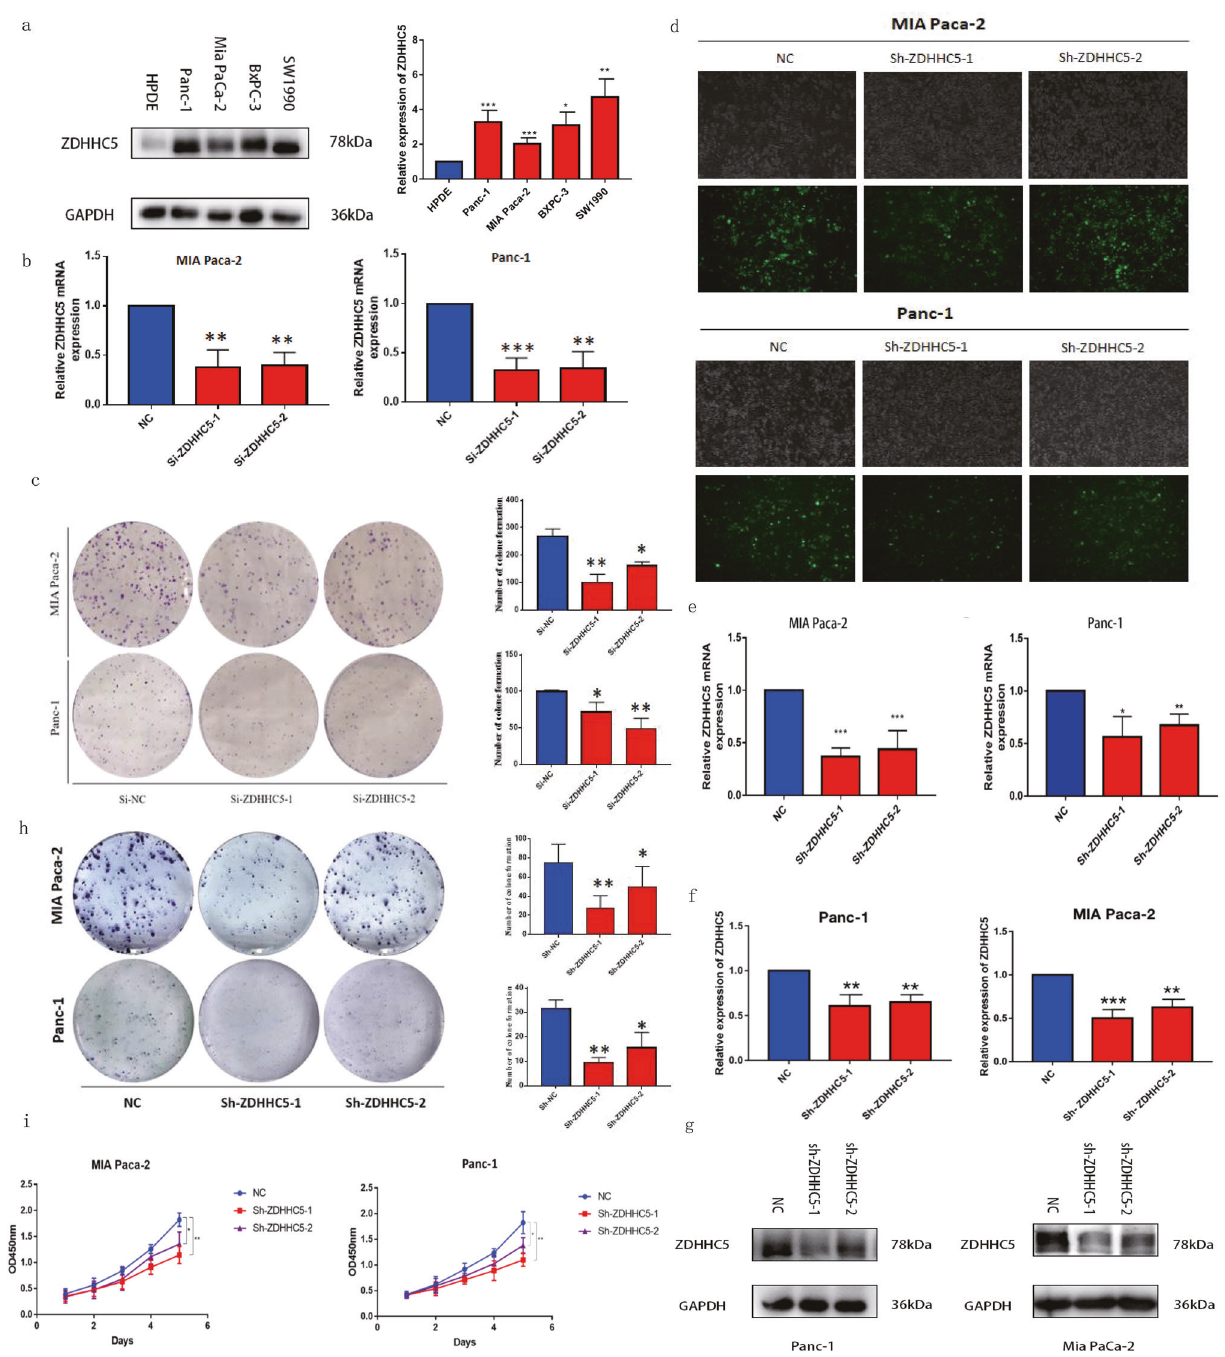
Fig. 2 In vitro evaluation of silencing ZDHHC5 anti-tumor effect. a ZDHHC5 is upregulated in pancreatic cancer cell lines. Western blot analyses of ZDHHC5 expression in HPDE cell and 4 PDAC cell lines. b ZDHHC5 mRNA expression after transfection analyzed by RT-qPCR. c After transfection, colony formation assay of cell viability in MIA Paca-2 and Panc-1 cell lines after cultured 15 days. d Establishment of stable ZDHHC5 knockdown pancreatic cancer cell lines. MIA Paca-2 and Panc-1 cells were transduced with a lentivirus vector containing negative control ShRNA (NC) or one of two ShRNAs against ZDHHC5 (Sh-ZDHHC5-1 and Sh-ZDHHC5-2) for 48 h. Morphology of MIA Paca-2 and Panc-1 cells was captured. e mRNA expression of stable ZDHHC5 knockdown cell lines were analyzed by RT-PCR. f , g Knockdown ef fi ciency on protein level was detected using Western blot. h After construction of stable ZDHHC5 knockdown cell lines, colony formation assay of cell viability in MIA Paca-2 and Panc-1 cell lines after cultured 15 days. i Transduced MIA Paca-2 and Panc-1 cells were cultured for 5 days post transduction. The absorbance at 450 nm was measured with a microplate analyzer every 24 h to assess cell growth. Data are expressed as mean ± SEM ( n = 3) * p < 0.05, ** p < 0.01, *** p < 0.001 in a , b , c , e , f , h and i .